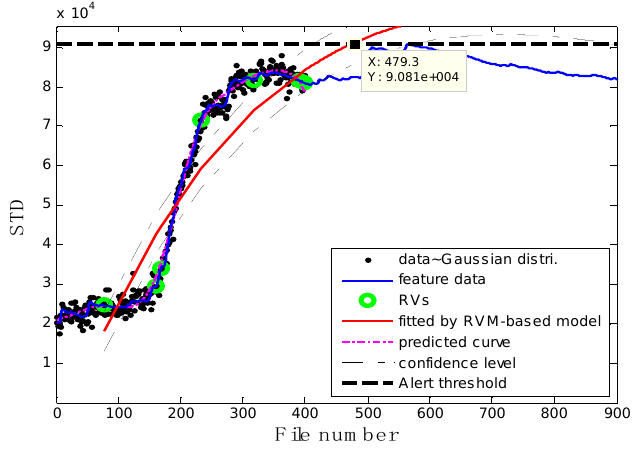
Figure 18. Inspection file number